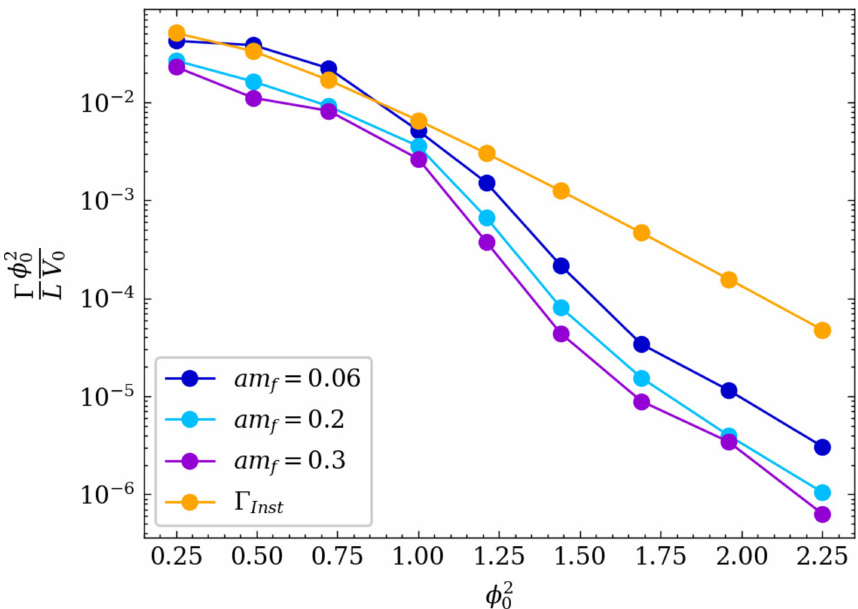
Figure 6 . The dependence of the nucleation rate on the lattice cut-off in 1+1 dimensions, for quantum- (cid:15) = 0 . 5 initial conditions and comparing to the instanton